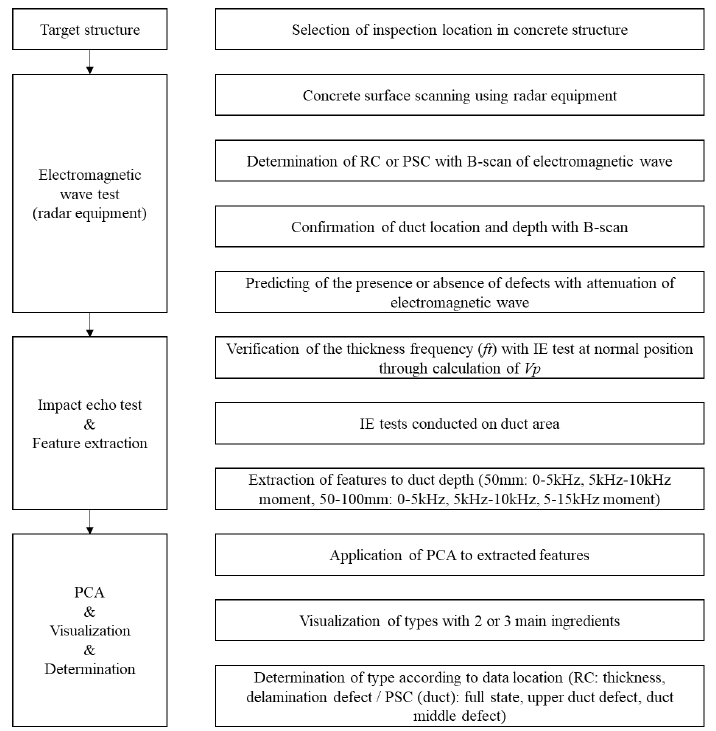
Figure 17. Defect type detection procedure of PSC structure using EM wave and